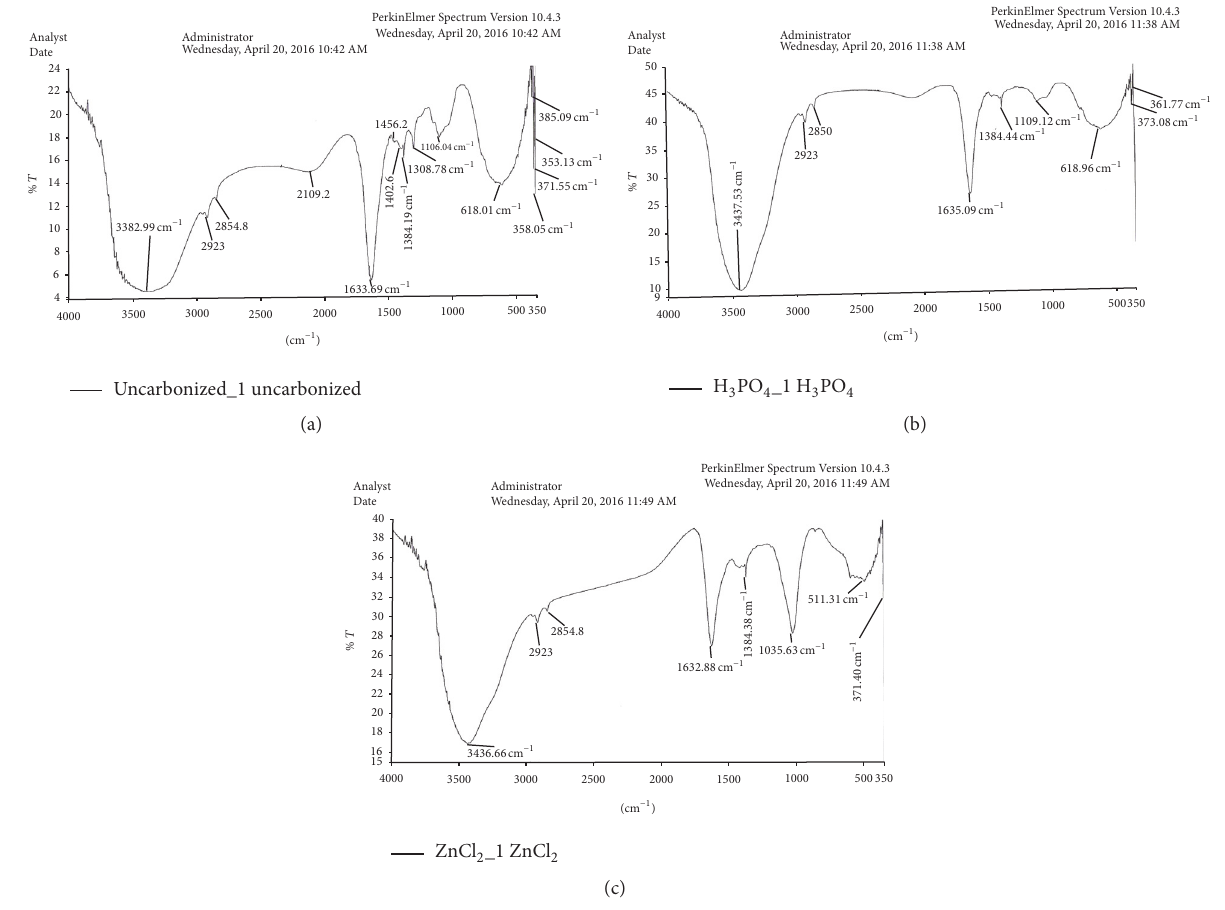
Figure 3: (a) FTIR analysis of UPC. (b) FTIR analysis of CPPAC. (c) FTIR analysis of CPZAC. UPC = untreated plantain carbon, CPPAC = carbonized plantain phosphoric acid activated carbon, and CPZAC = carbonized plantain zinc chloride activated